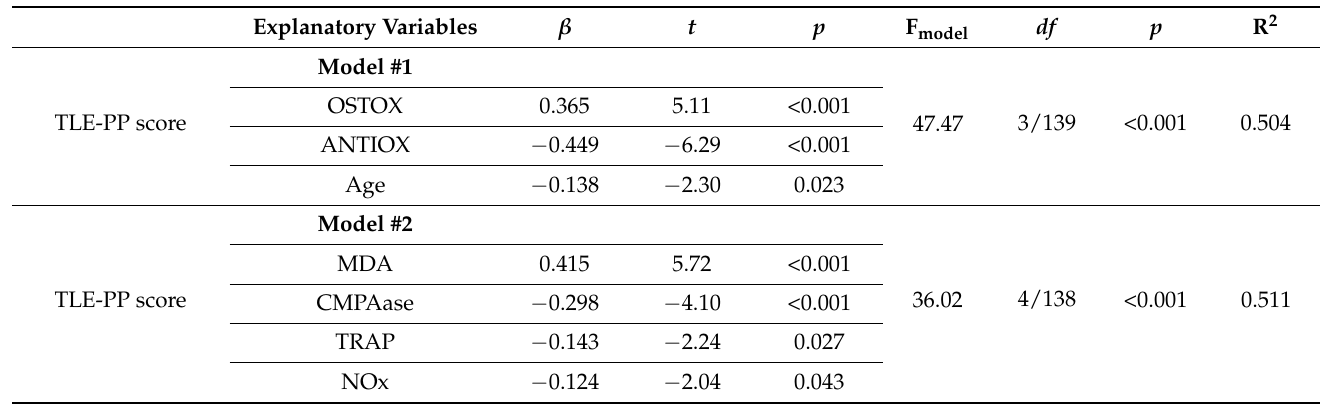
Table 2. Results of multiple regression analyses, with the phenome score or temporal lobe epilepsy features as dependent variables and biomarkers as explanatory